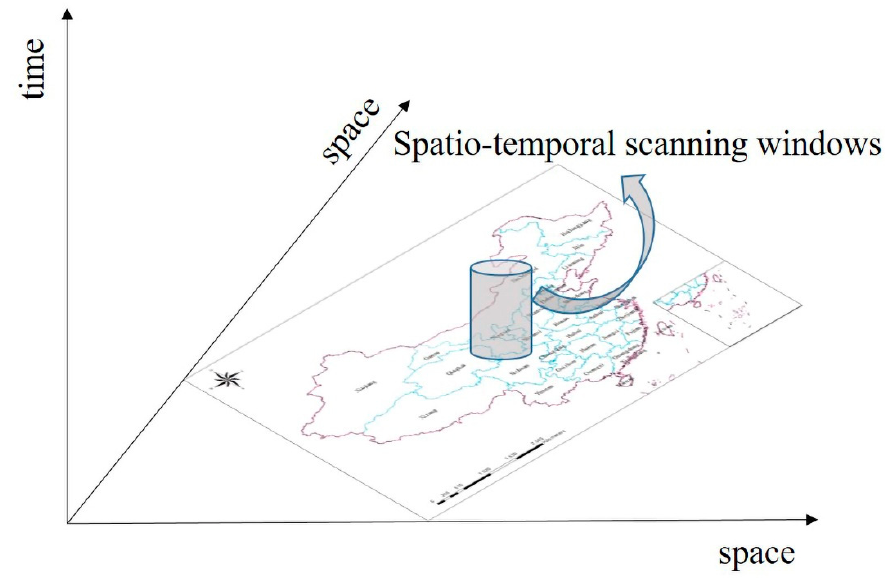
Figure 1. Schematic diagram of the spatio-temporal scanning model (STSM).